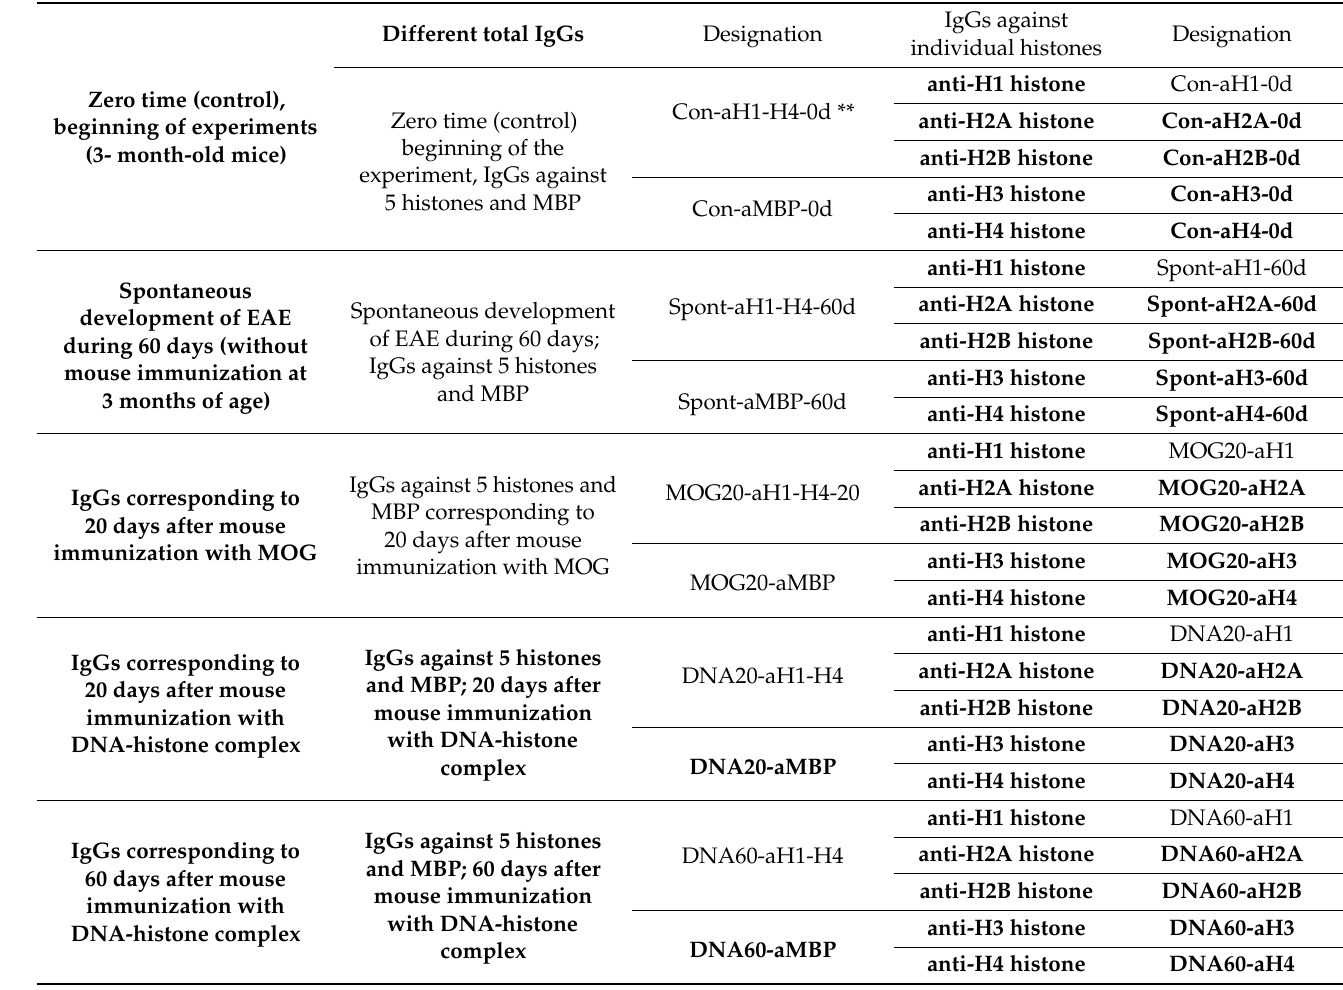
Table 1. IgGs against the five histones (total), MBP, and five individual histones corresponding to different stages of EAE development